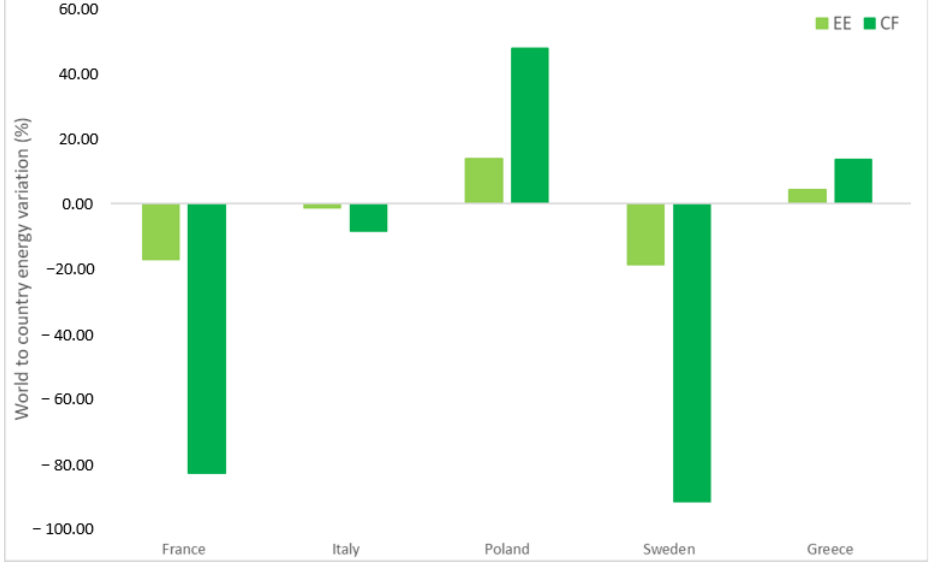
Figure 7. Variation (%) of EE and CF compared to world averaged values. Data refer to the process based on the use of sulfuric acid [21].